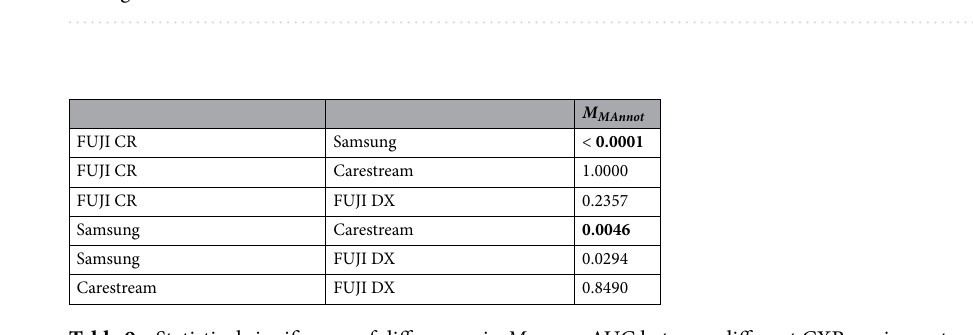
Table 9. Statistical significance of differences in M MAnnot AUC between different CXR equipments on CHVNGE according to the Venkatraman test. Bold indicates statistical significance with Bonferroni correction ( p < 0.0083 ).